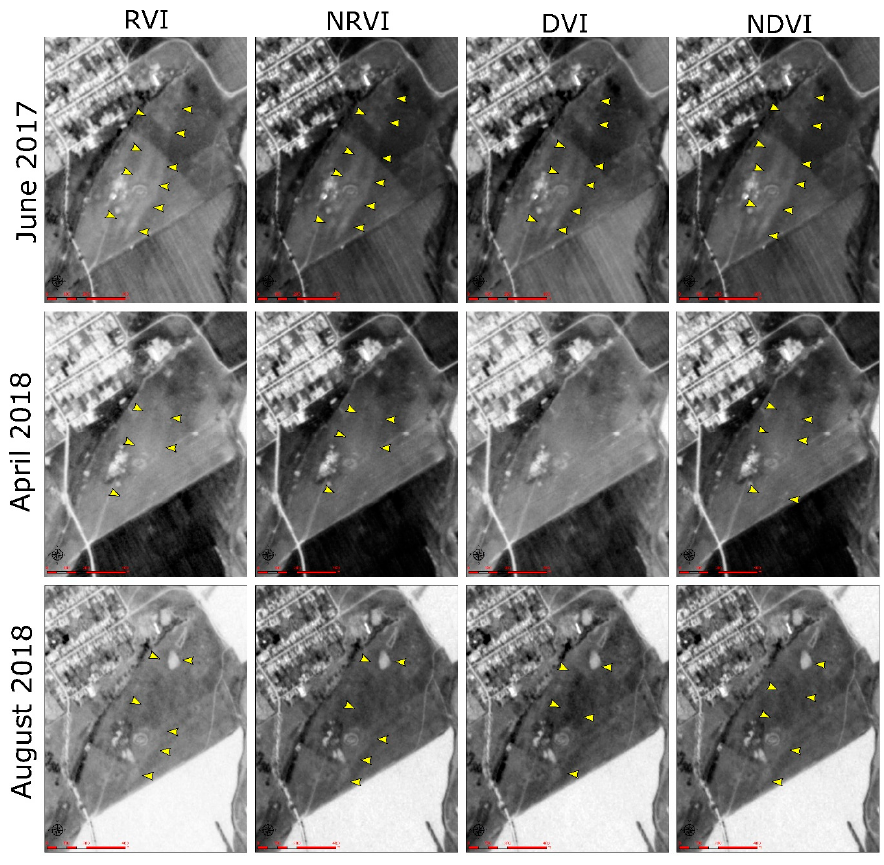
Figure 7. Results of RVI, NRVI, DVI and NDVI algorithms. The yellow arrows indicate the features shown in each image.